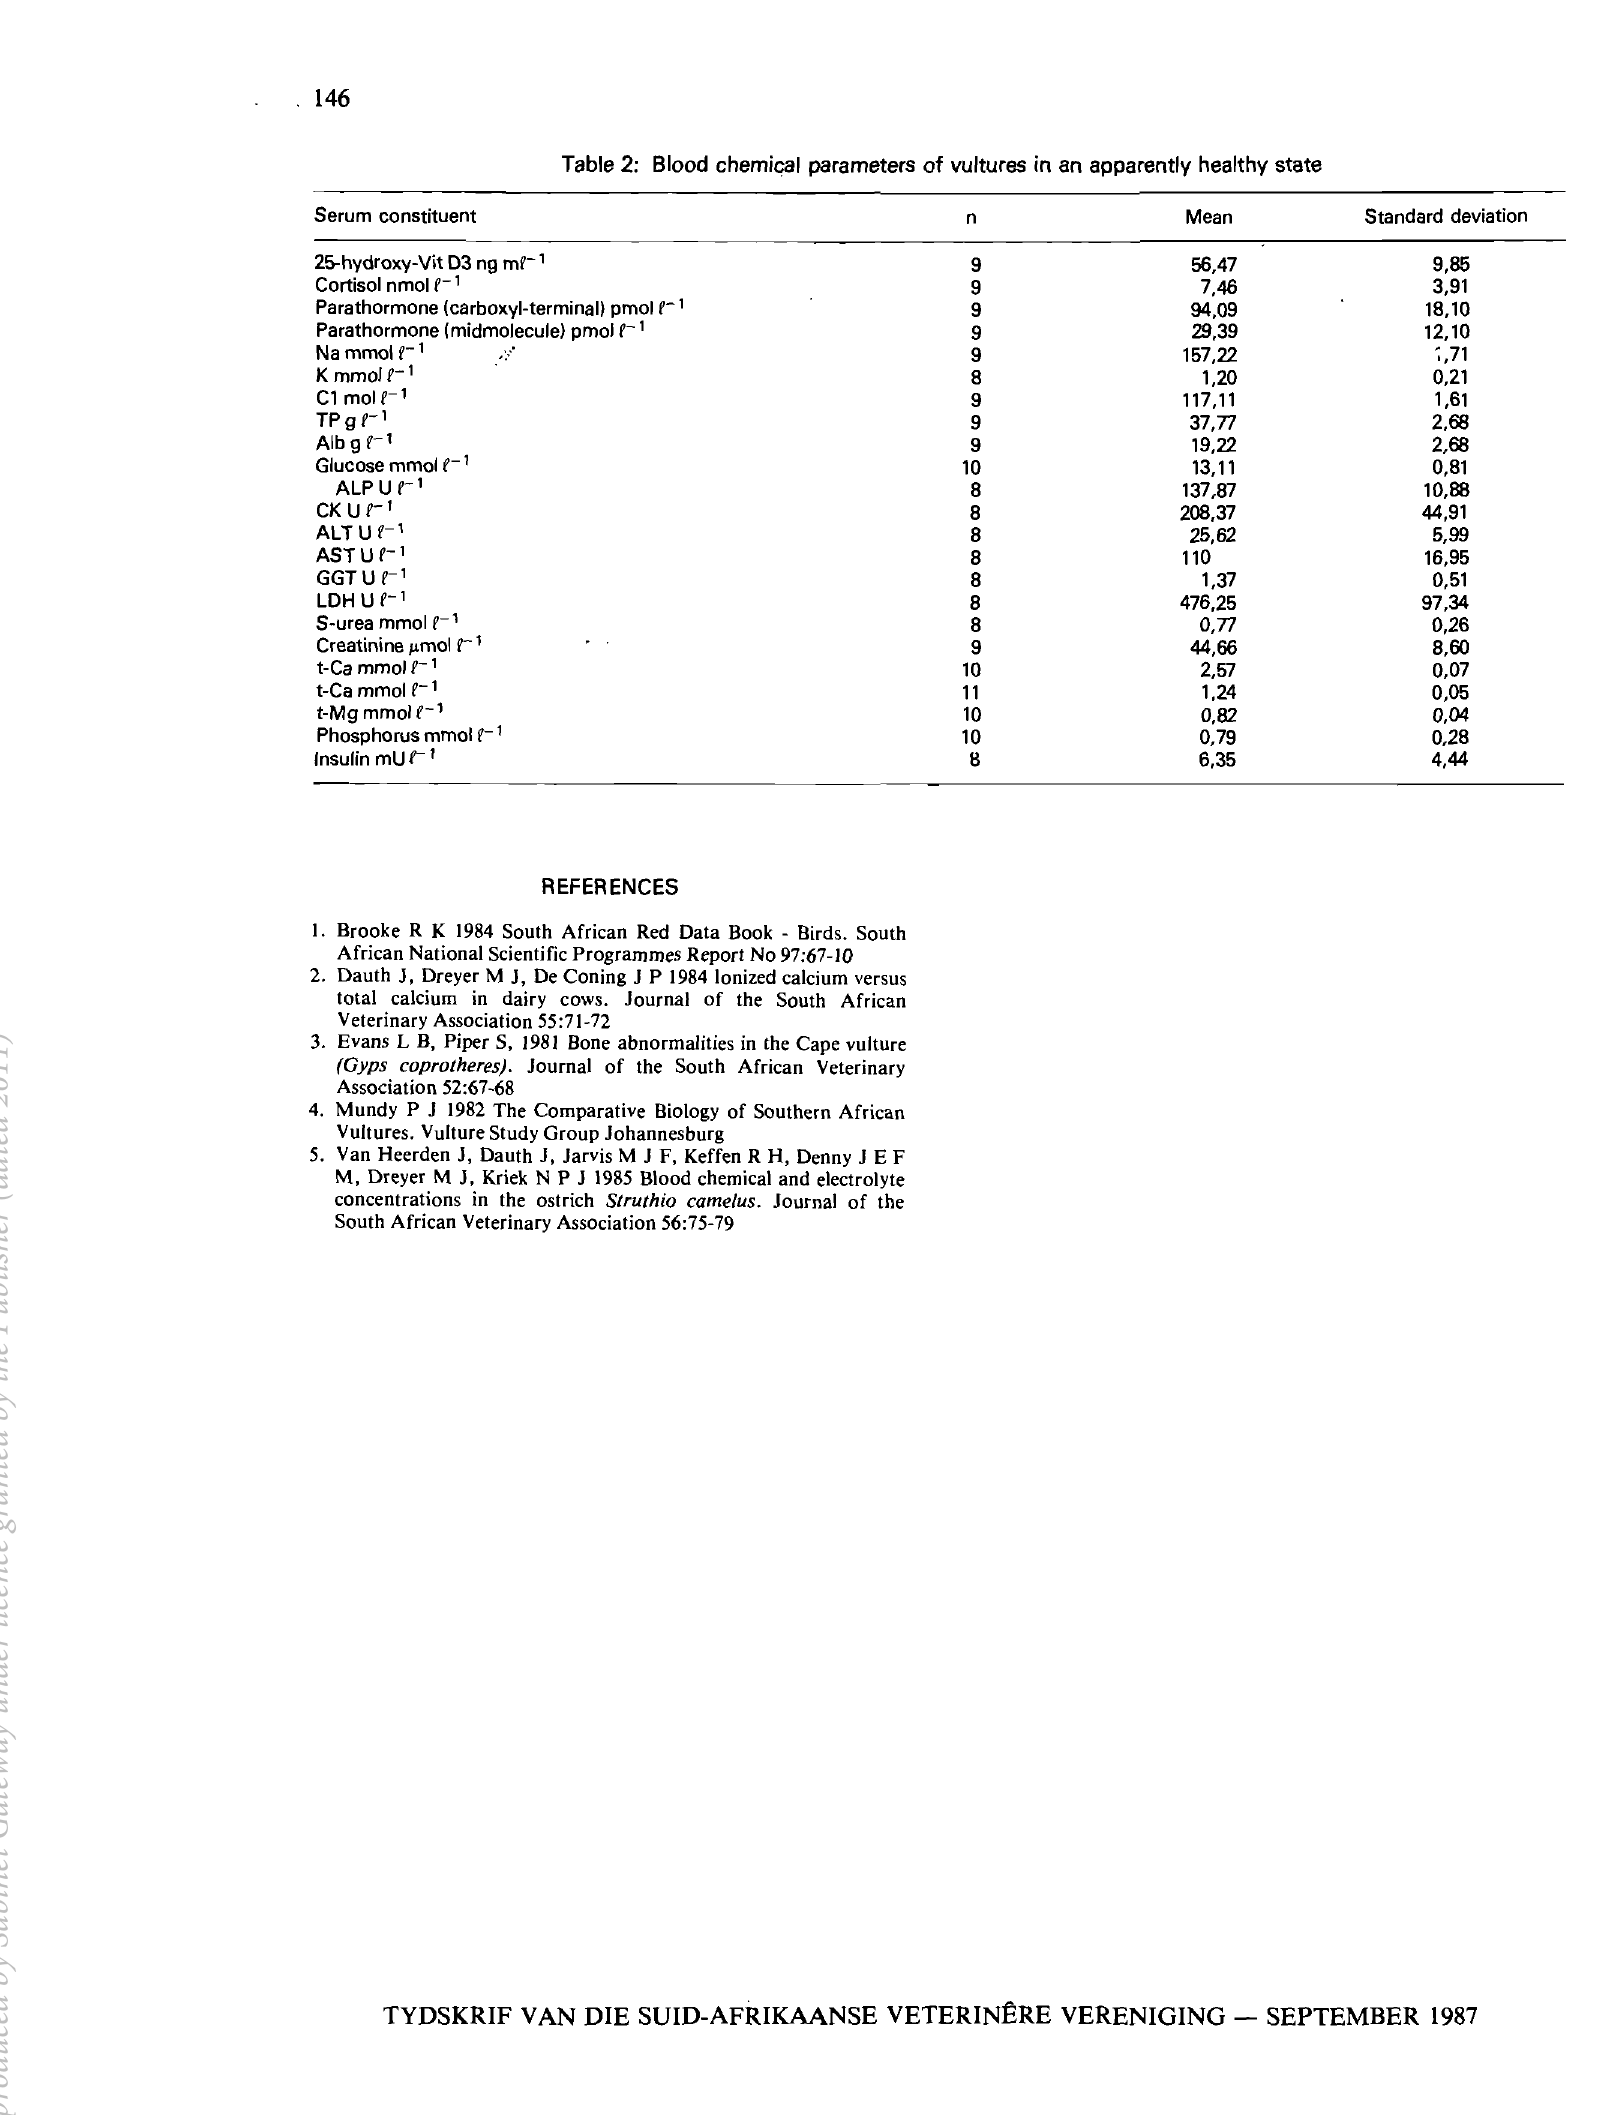
Table 2: Blood chemical parameters of vultures in an apparently healthy